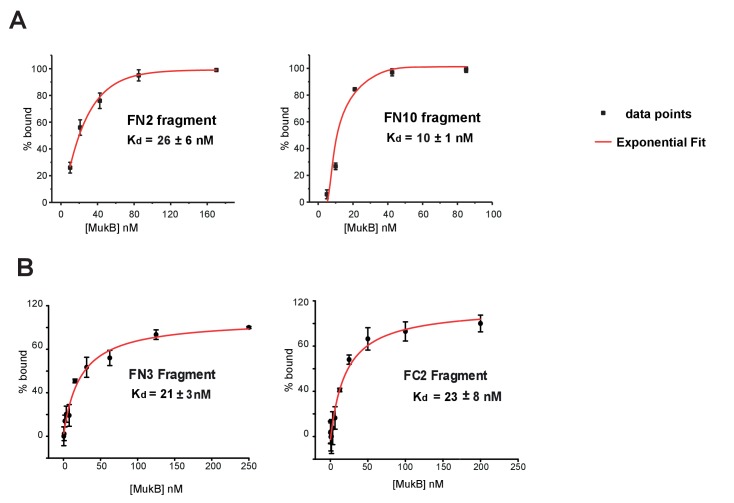
Binding affinities of MukF fragments to MukB.(A) FCS measurements of FN2 and FN10 binding to MukB. Cy5 labelled fragments were at a fixed ~10 nM concentration; exponential fits to data points were used to extract Kds. Error bars represent S.D. of three independent experiments. (B) FPA measurements of FN3 and FC2 binding to MukB. Cy5 labelled FN3 and FC2 fragments were at concentrations 5 nM and 9 nM, respectively.10.7554/eLife.31522.009Figure 3—figure supplement 3—source data 1.Binding affinities of MukF fragments to MukB.